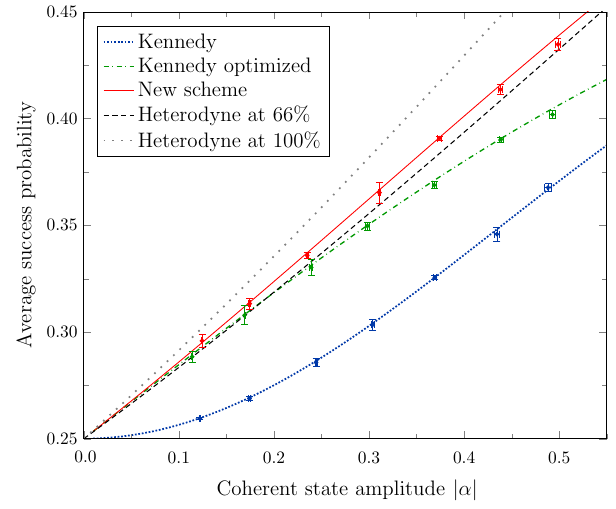
FIG. 5. Average success probability of distinguishing QPSK coherent states as a function of the signal amplitude α for differ- ent receivers. The theoretical success probability of our scheme in the experimental condition is shown with a solid red line, together with experimental data points. The success probabili- ties from heterodyne [from Eq. (11)] measurements accounting for 66% and 100% detection efficiencies are shown with dashed black and dotted gray lines, respectively. The blue dotted line is for a conventional nulling Kennedy receiver [44], shown together with experimental data points. The green dash-dot line is for the Kennedy receiver with optimized displacement amplitudes [45], also shown with experimental data. Error bars denote one standard deviation from five